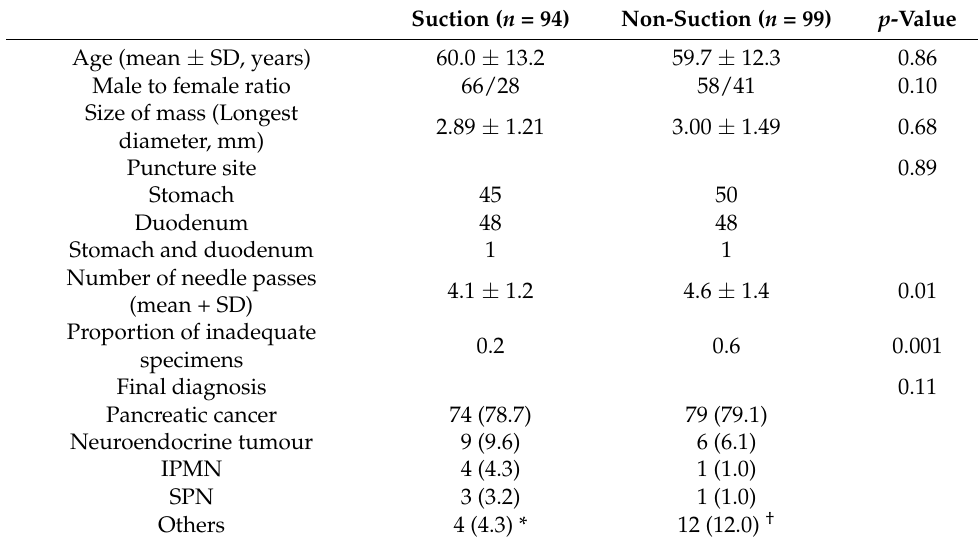
Table 1. Baseline characteristics of enrolled patients (study